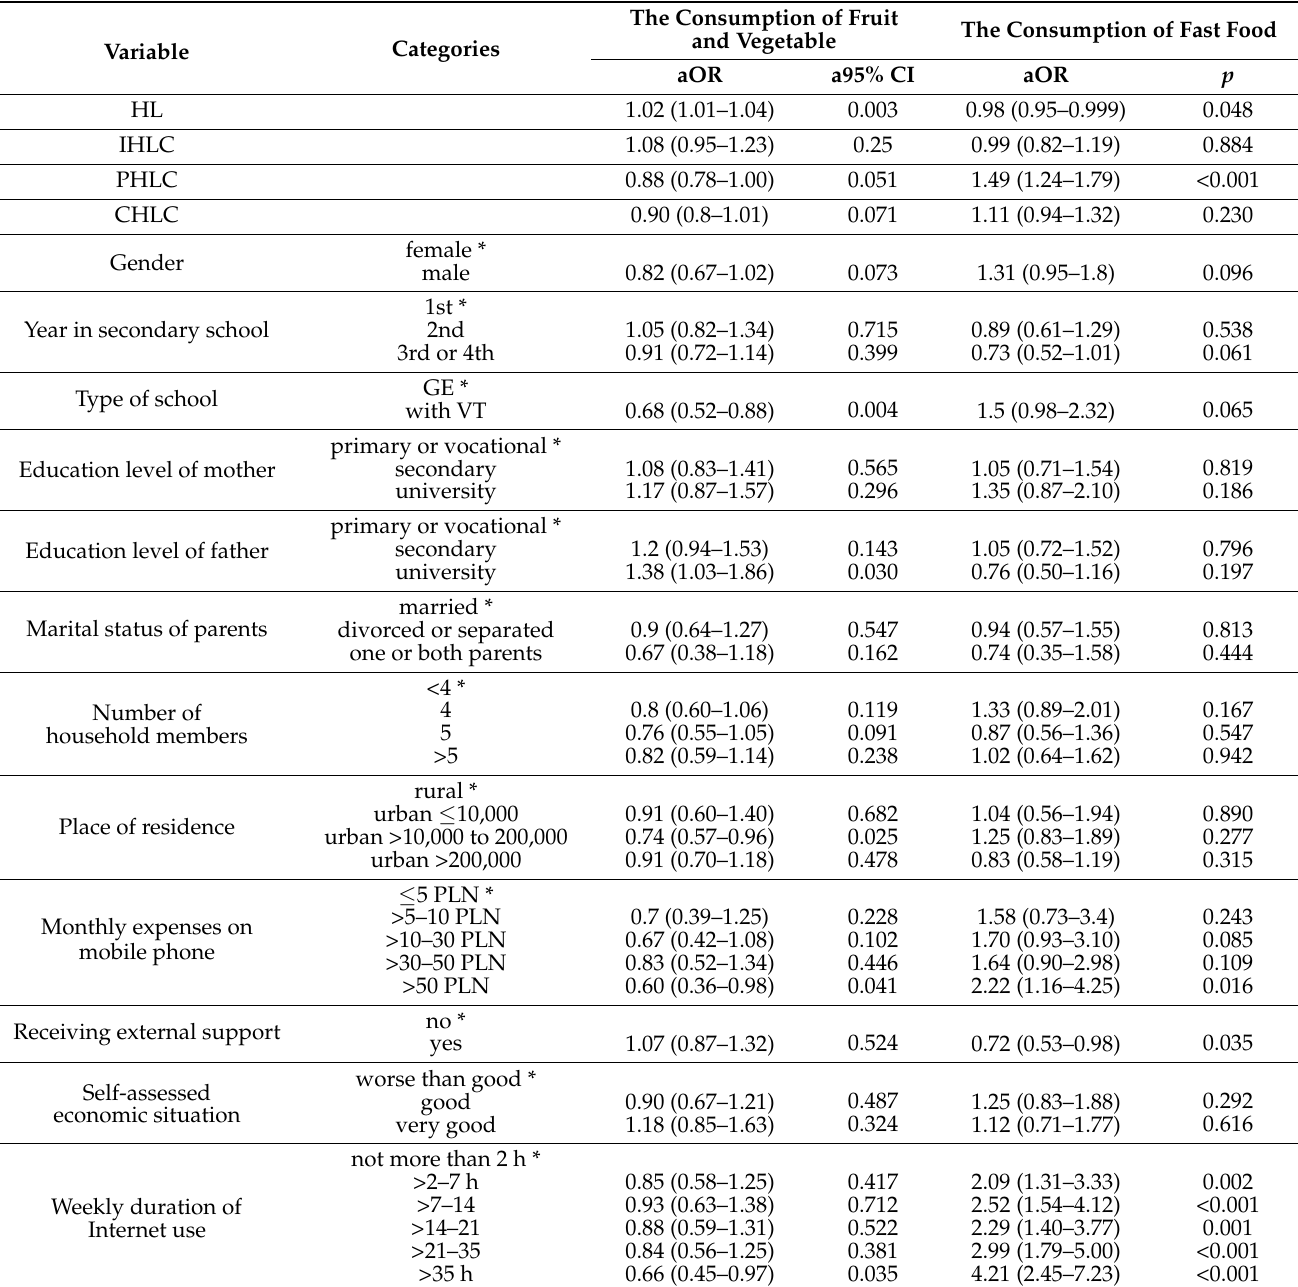
Table 4. Multivariate logistic regression models for the consumption of fruit and vegetables and the consumption of fast